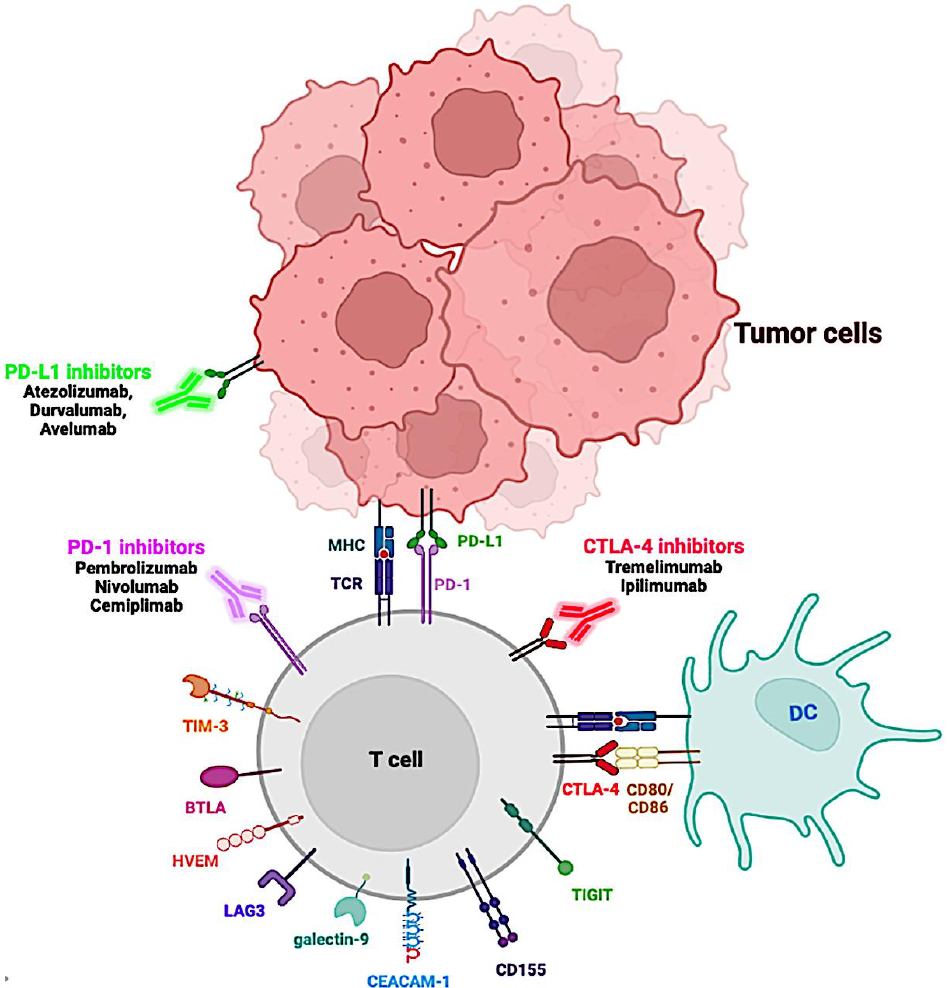
Figure 2. FDA-approved immune checkpoint inhibitors as a therapeutic intervention in cancer. T cells are activated through antigen presentation by major histocompatibility complex (MHC) molecules on the surface of tumor cells or on antigen-presenting cells (APC) such as dendritic cells (DC), recognized by the T cell receptor (TCR). Activated T cells will upregulate the expression of co-inhibitory cell surface receptors such as PD-1 and CTLA-4. Binding of PD-1 to its ligands, PD-L1, or PD-L2, will inhibit signaling downstream of the TCR, thus downregulating T cell activity. Antibody therapies that target PD-1 or PD-L1 can reactivate exhausted T cells at the tumor location, increasing their activity and allowing T cells to destroy tumor cells. Binding of CTLA-4 to its ligands, B7, CD80, or CD86, suppresses T cell activity. By blocking CTLA-4 interaction with anti-CTLA-4 antibodies, T cell proliferation will be activated. Created with Bio.Render.com.